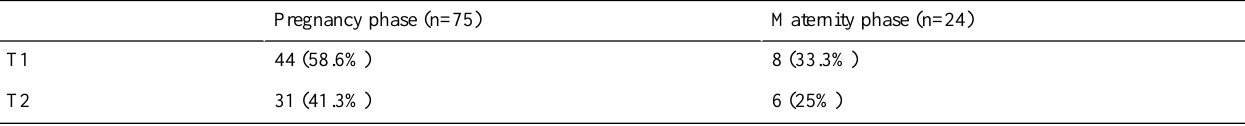
Table 3. The response rate across program phase and assessments.